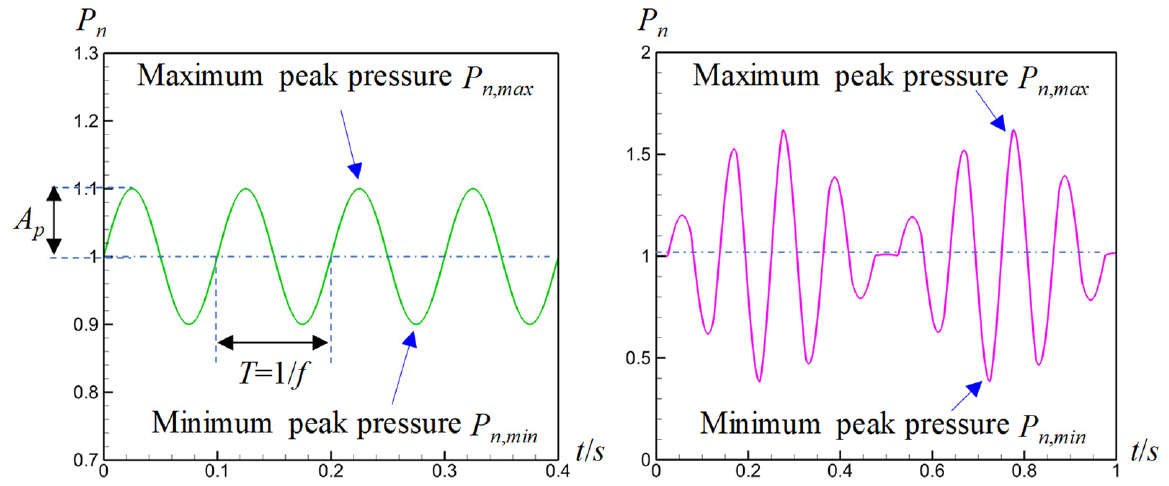
Figure 4. Sketch map of normalized pressure P n , where P n , max is the maximum peak pressure and P n , min is the minimum peak pressure. The left part is the sine pulse applied at the inlet. The right part is the pressure–time curve somewhere in the pipe. All normalized pressures are dimensionless quantities.